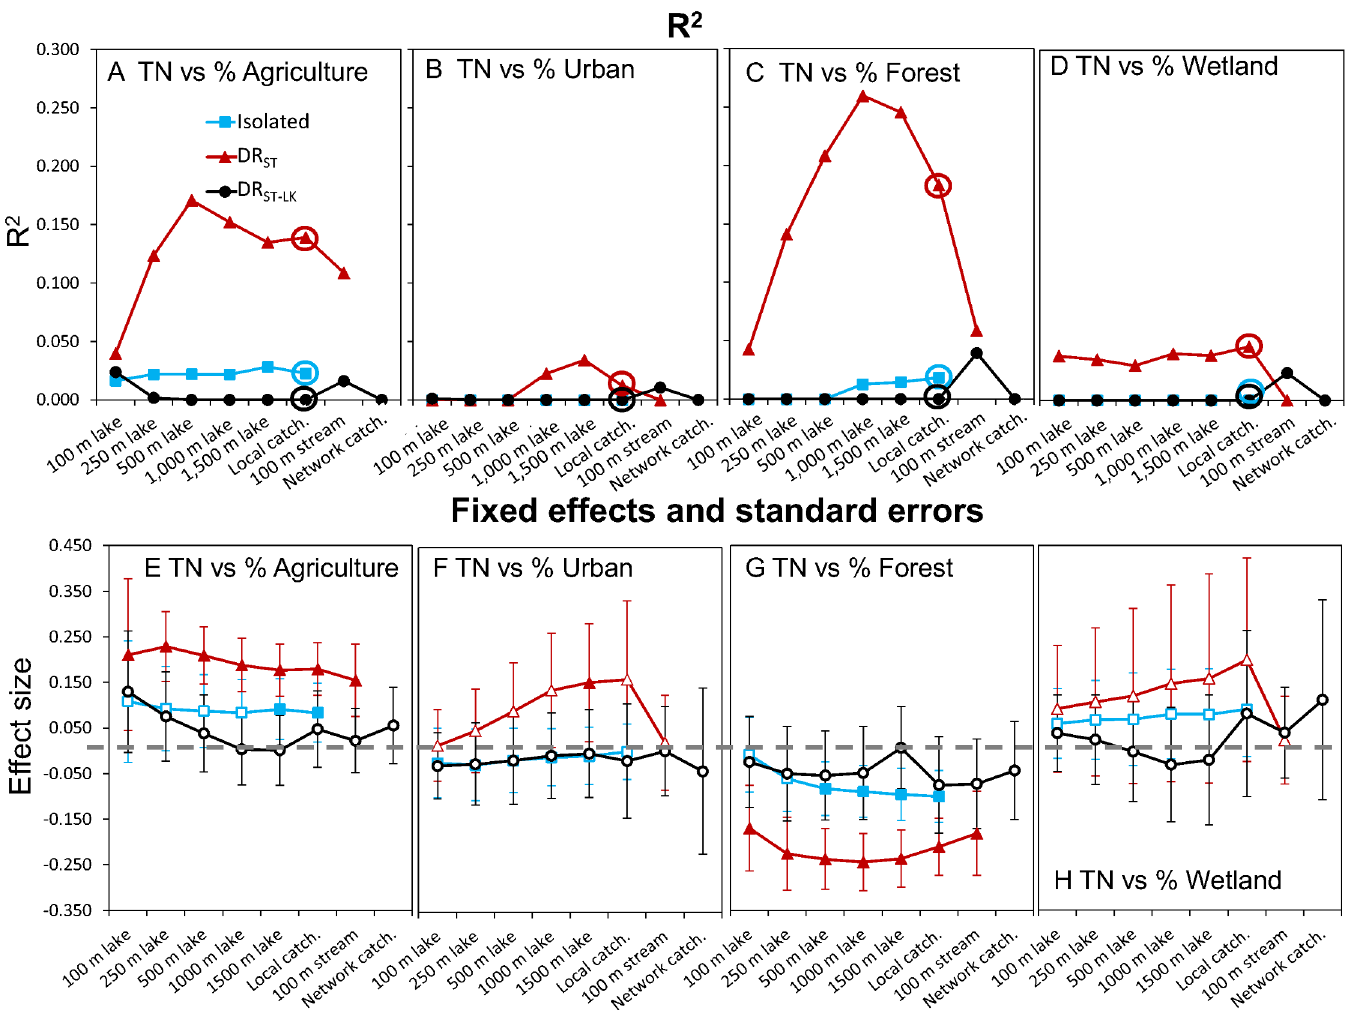
Fig 5. Model fit and effect sizes for the fixed effects in models of land use-lake total nitrogen (TN). For the relationships between TN and individual LULC types by lake class and spatial extent, the R 2 (A-D) and slopes (E-H) from mixed-models with random intercepts and fixed effects of the LULC type. Individual models were fit for each lake class and spatial extent of a particular LULC type combination (i.e., for % agriculture land use, 21 individual models were fitted). In plots E-H, the error bars are confidence intervals (CI ’ s) of the slopes from the above models. Filled symbols are for the fixed effect slopes in which the CI does not overlap zero. Note, we show lines connecting the points of each lake class for ease of comparison across lake classes